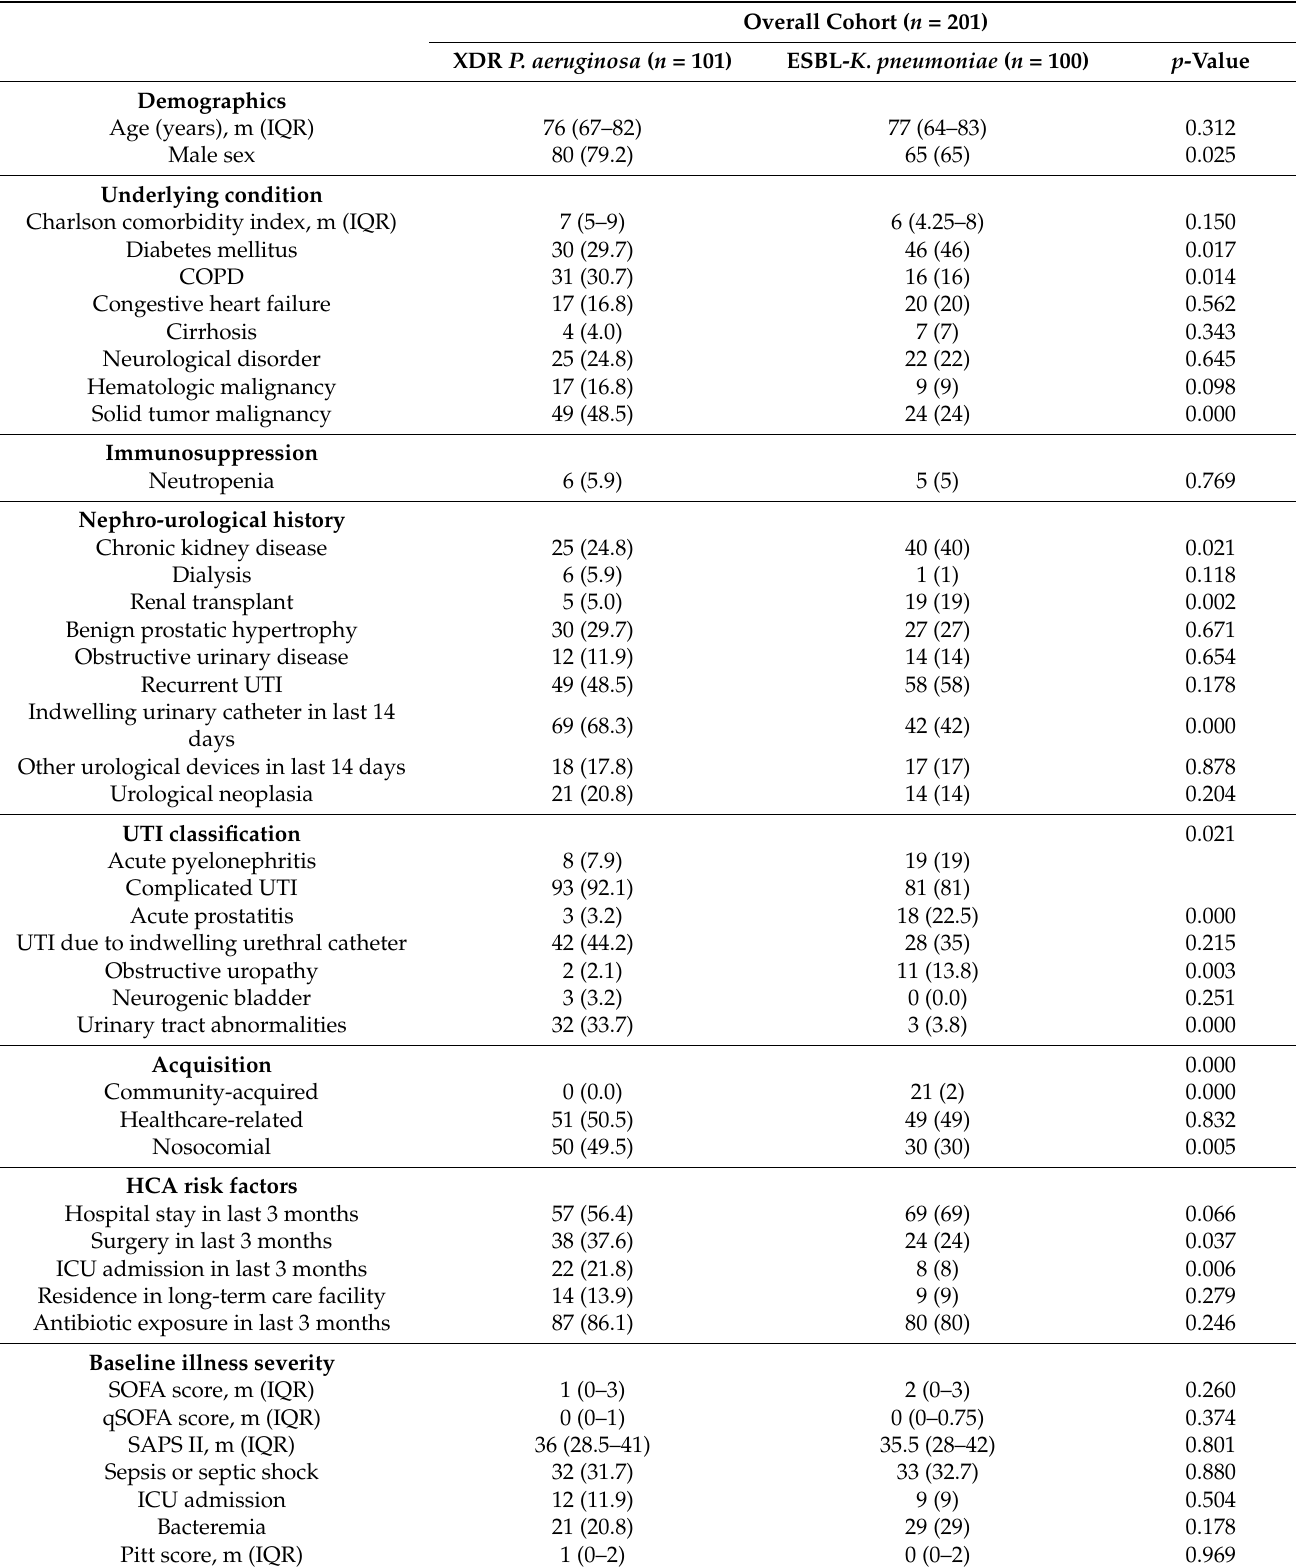
Table 1. Baseline characteristics of patients included in the study and comparative analysis according to